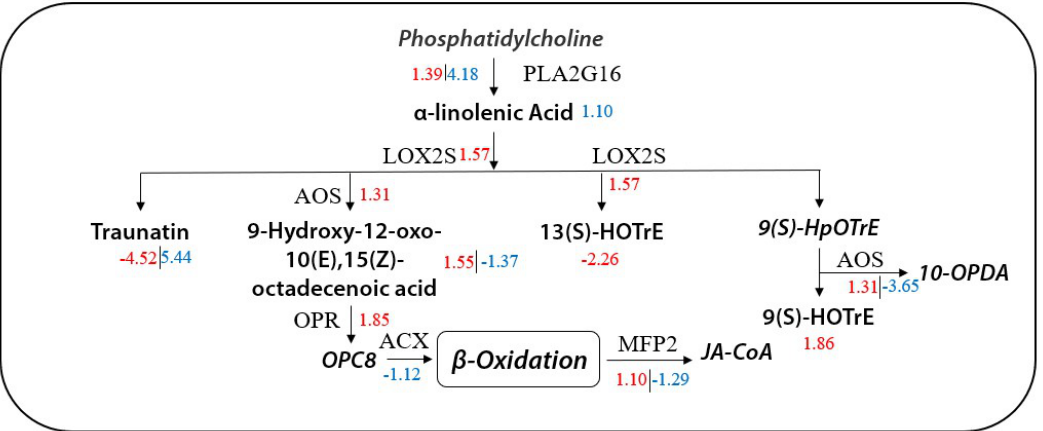
Figure 10. Metabolic network diagram of maize α-linolenic acid under T1 and T2 drought stress. Different nodes represent metabolites, and the lines represent the names of participating gene families. The red numbers indicate the upregulation or downregulation of metabolites or genes during T1. The blue numbers represent the upregulation or downregulation of metabolites or genes during T2. The fonts in italics represent unidentified metabolites, and some undetected compounds are not displayed.